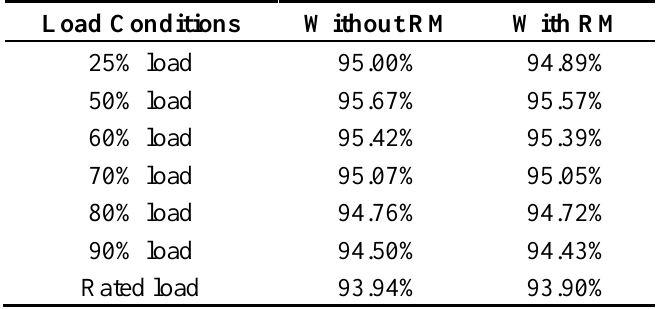
Table 2. Efficiency records under different load